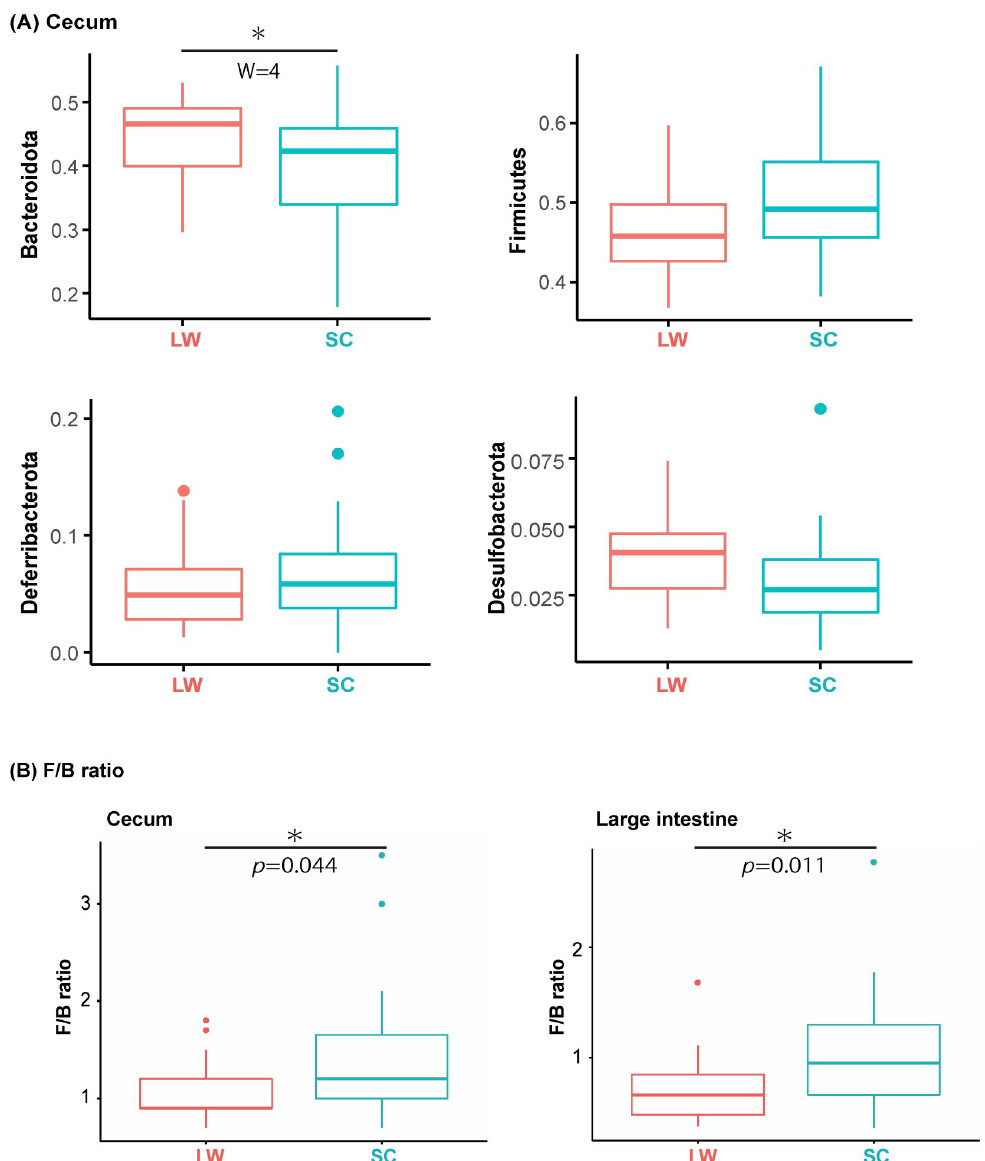
Fig 3. Bacteroidota in the cecum differ significantly between summer- and winter-mimicking conditions. (A) Analysis of composition of microbiomes (ANCOM) was performed on the four major phyla that constitute the cecum and large intestine flora of CBA/N mice. Boxplots showing bacterial genera with significantly different relative abundances depending on seasonal conditions (LW, SC) (cecum, LW n = 22; SC n = 24). Plots show medians and interquartile ranges. W represents the number of null hypotheses rejected when statistics are performed to see if there is a difference between samples for a particular bacterium. (B) The Firmicutes/Bacteroidota (F/B) ratios in cecum (left) and large intestine (right) were compared between LW and SC conditions, respectively. Box plots show medians and interquartile ranges, and symbols indicate the significant differences by t -test ( � ; p <